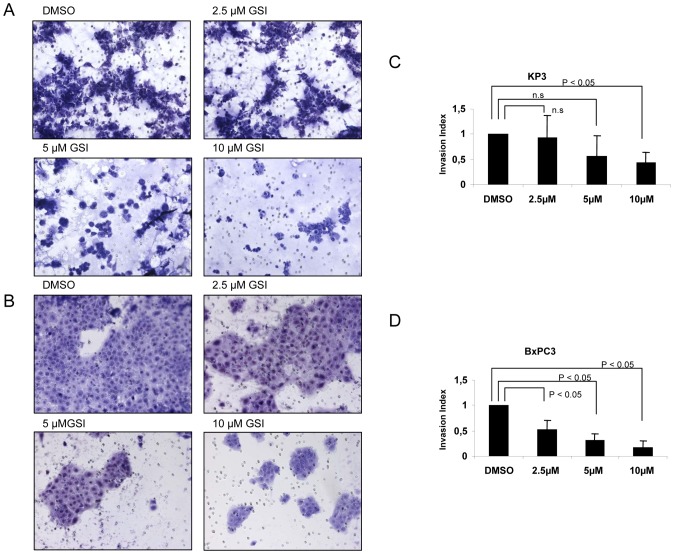
GSI IX attenuate invasion of human pancreatic cancer cells.KP3 and BxPC3 cell lines were treated for 48 h with control (DMSO) and GSI (2.5 µM, 5 µM, 10 µM) to investigate the effect of GSI on invasiveness of pancreatic cancer cell lines. The number of cells that invaded through the membrane was determined by light microscope (20× magnification) counterstained and invasion index was calculated as described in Material and Methods and plotted in bar graphs. Both (A) KP3 and (B) BxPC3 showed significant decrease in number of invading cells by light microscope. Note the slight difference of invasion index between (C) Kp3 and (D) BxPC3 cells. P values are calculated with ANOVA analysis of variance along with Bonferroni post test. The error bar represents standard deviation. Differences were considered as statistically significant when the P-value was less <0.05 and non significant “n.s.” when the P-value was higher >0.05. The error bar represents standard deviation.